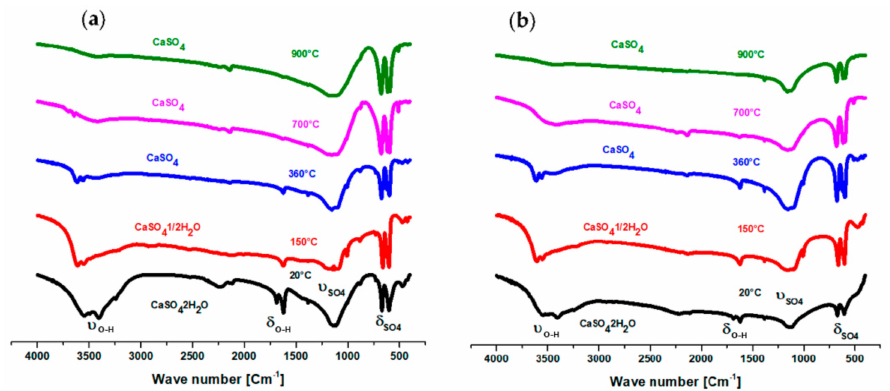
Figure 7. Infrared curves for Agadir ( a ) and Safi ( b ) gypsum at di ff erent temperatures.